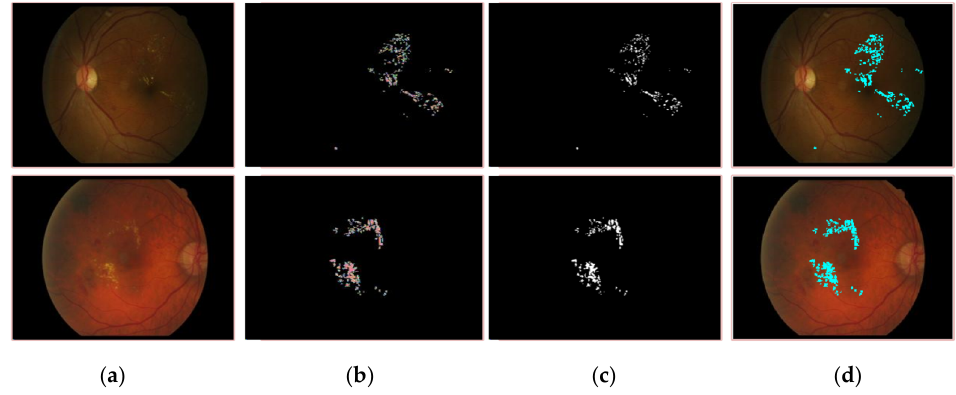
Figure 5. Segmented EX lesions of the e-ophtha-EX dataset. ( a ) Input image, ( b ) proposed segmen- tation, ( c ) ground truth image, ( d ) segmented region mapped on the input image.